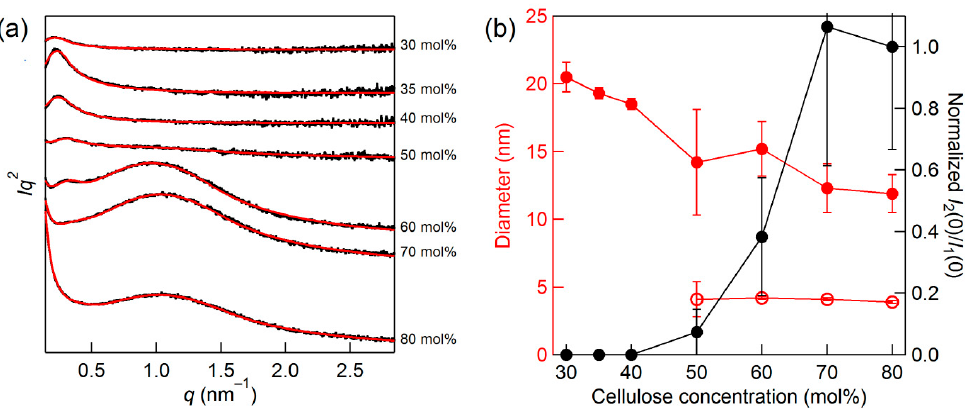
Figure 4. ( a ) SAXS patterns of the cellulose/[Emim][OAc] mixtures in the Kratky plot for the concentrations of 30–80 mol %. Black curves are the observed patterns, while the red curves are the theoretical patterns comprising the sum of two generalized Guinier–Porod functions and one Porod function; ( b ) Red: Diameter changes of the aggregated structures, assuming a sphere. Filled and open symbols are for large and small aggregates, respectively. Black: The normalized I 2 (0)/ I 1 (0) change, where I 1 (0) and I 2 (0) are the scattered intensities of the aggregates at q = 0. The subscripts 1 and 2 are for the large and small aggregates, respectively. The ± signs represent standard deviation produced in the fitting procedures based on a nonlinear regression method. Table 1. SAXS parameters obtained from Figure 4a. The subscripts 1, 2, and s are for the large aggregates, small aggregates, and shoulder scattering, respectively. The ± signs represent standard deviation produced in the fitting procedures based on a nonlinear regression method.